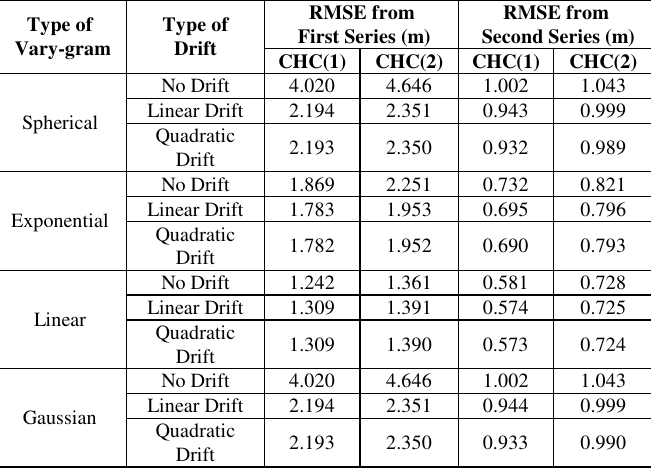
Table 5: Results from Kriging Method